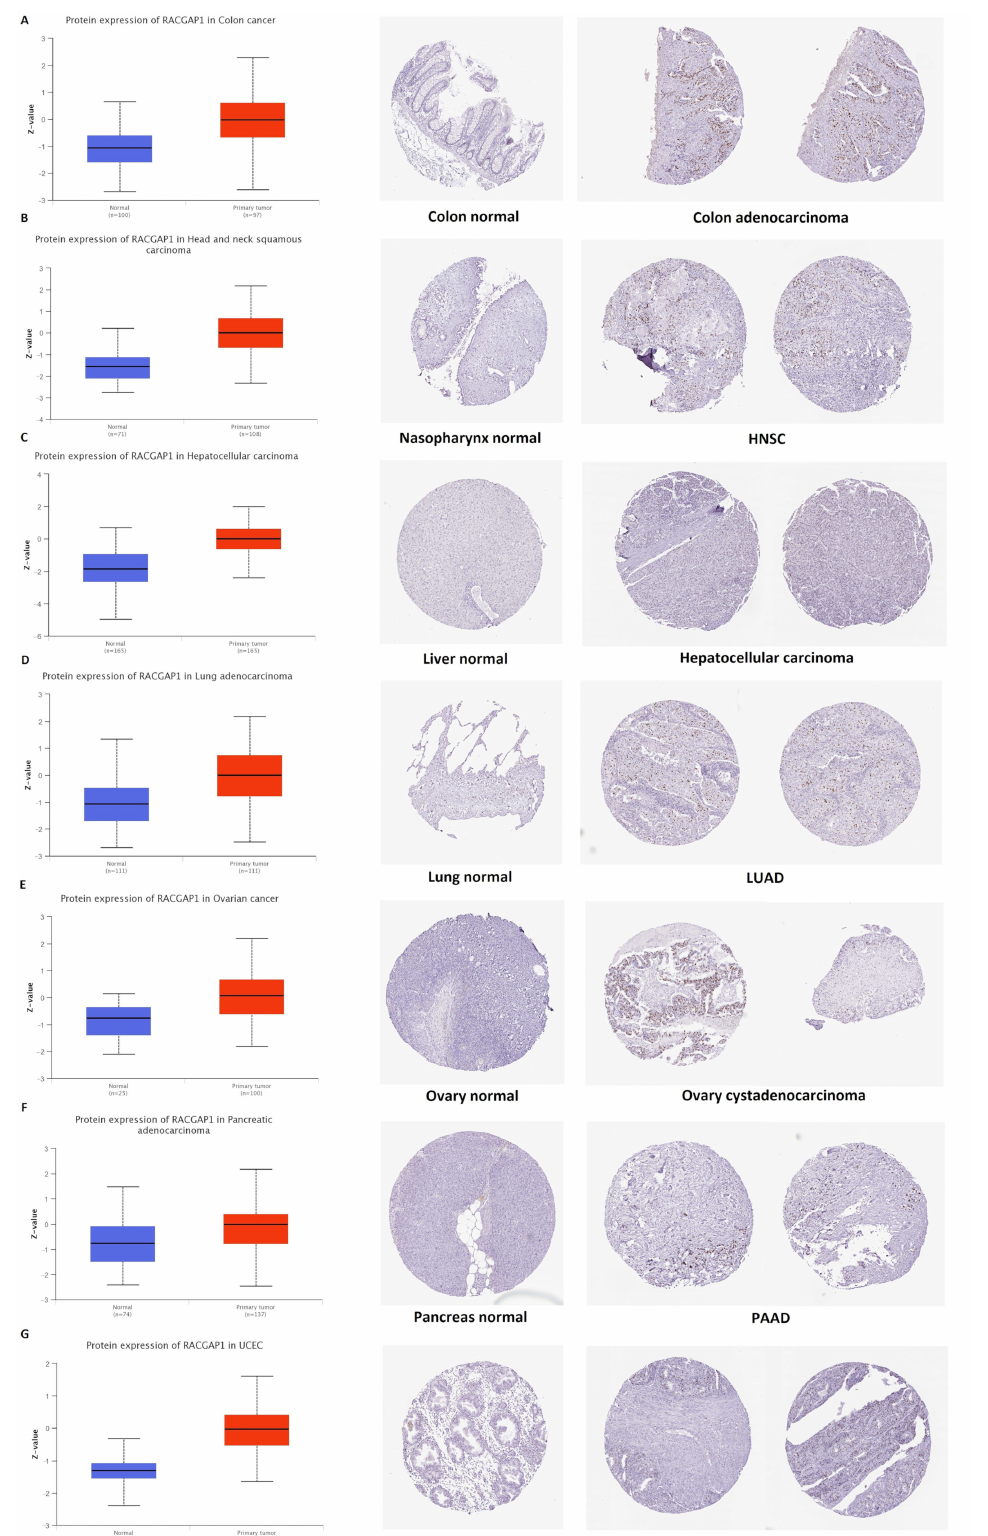
Figure 2. Tumors experienced a statistically significant higher RACGAP1 protein expression in the tumor sample versus normal one ( left side), and IHC staining for normal tissue ( middle ) and cancerous one ( left ) demonstrated the same results. ( A ) Colon; ( B ) nasopharynx; ( C ) liver; ( D ) lung; ( E ) ovary; ( F ) pancreas; ( G )